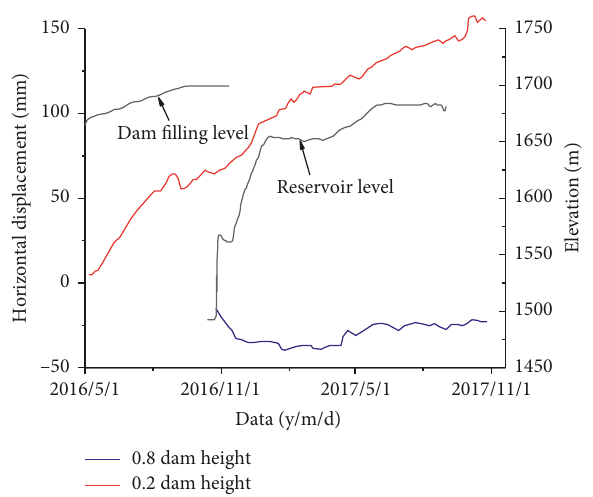
Figure 9: Horizontal displacement of the downstream side of the Changheba core.